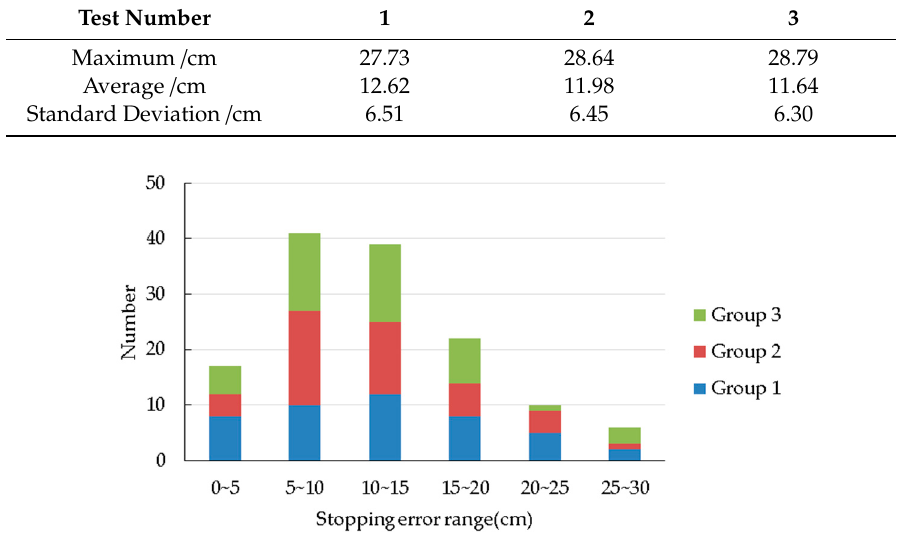
Figure 14. Stopping error distribution.